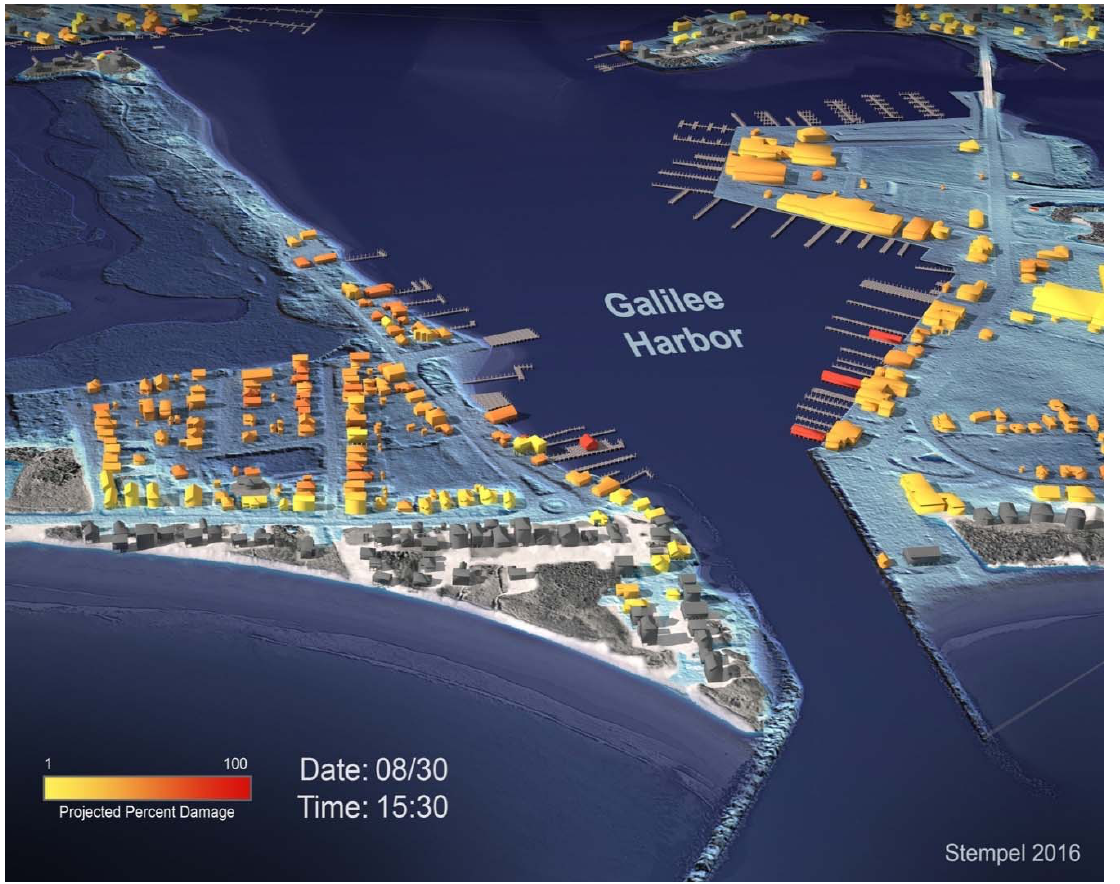
Figure 1. Rendering made during development of the real-time methodology depicting impacts of hurricane Carol (1954) on individual structures in the port of Galilee, RI, USA at current (2016) buildout. Image: Authors.